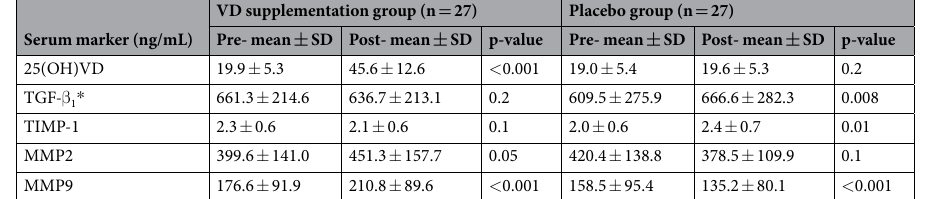
Changes of serum or delta ( Δ ) levels (ng/mL)